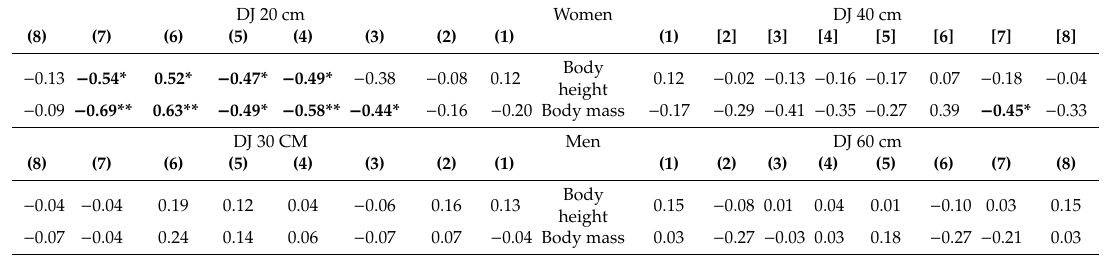
Table 4. Comparison of the Spearman rank correlation coe ffi cients calculated for selected somatic parameters and kinematic parameters of RJ at p <